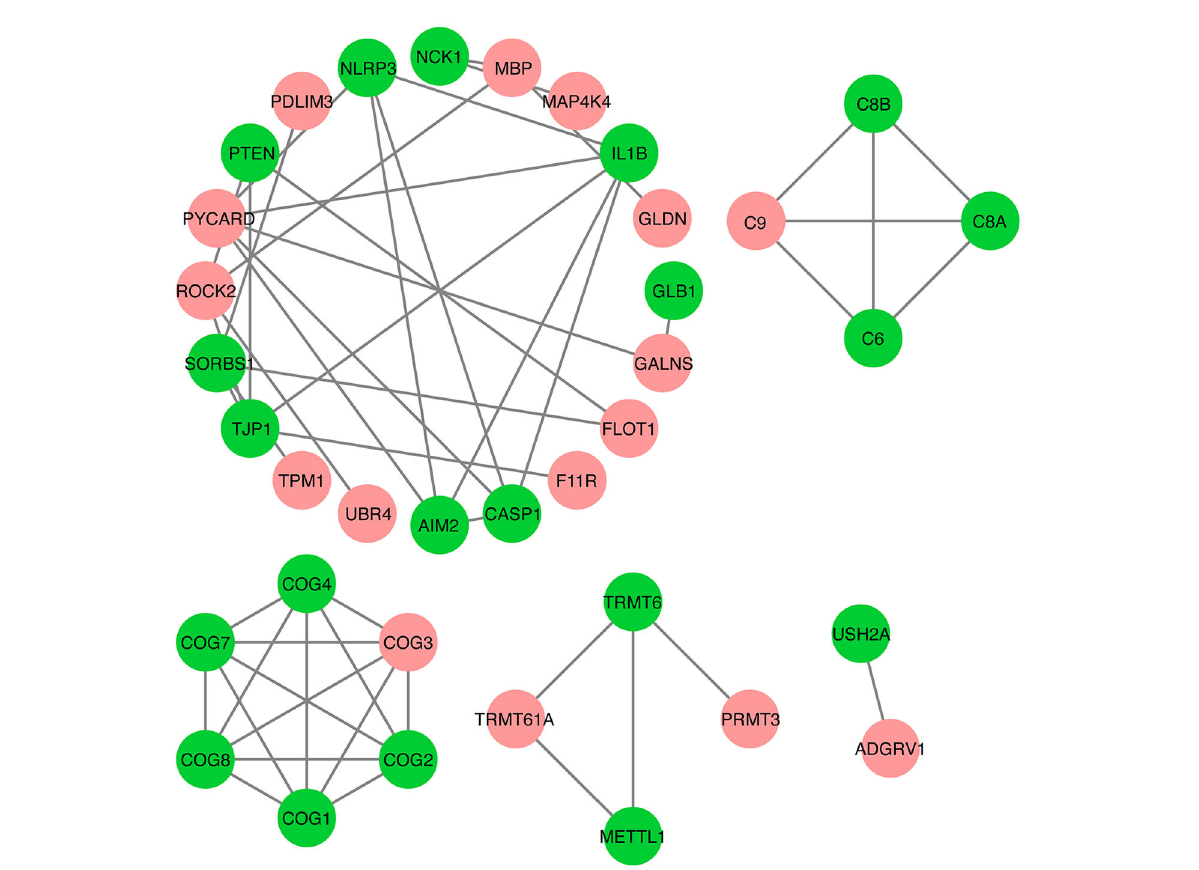
FIGURE5 Protein–protein interactions analysis for differentially abundant proteins (DAPs). The red nodes represent DAPs, while the green nodes represent other proteins that interact with DAPs. The edge represents interactions between